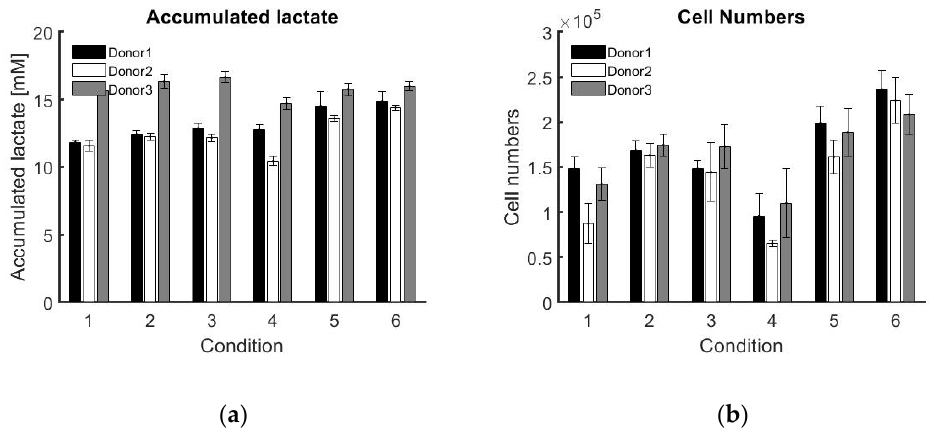
Figure 3. Average results with error bars for the triplicate experiments of each individual donor with each specific medium replacement strategy. ( a ) Total accumulated lactate produced after 5 days of cell culture (mM). ( b ) Cell numbers counted at the end of the cell culture period. Table 2. Total amount of cells harvested after the cell culture expansion, which is averaged over the triplicates for each donor and condition (100,000